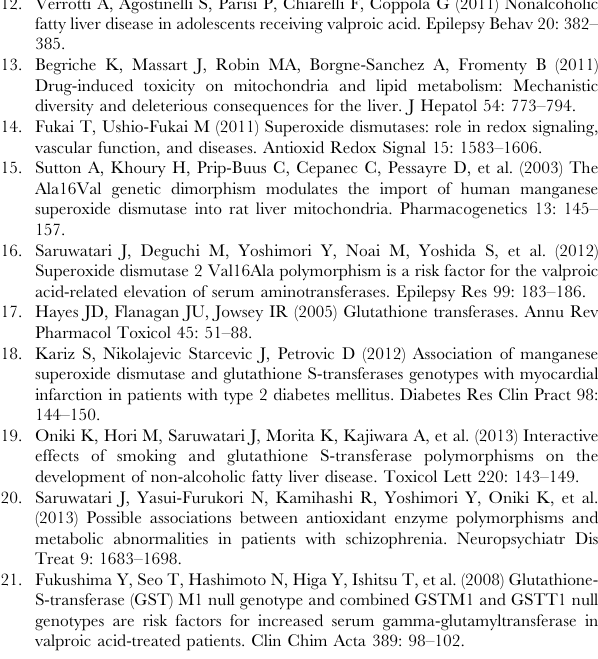
Figure S1 The goodness of fit of the final population PK model. The population-predicted (A) and individually-predicted (B) versus observed VPA concentrations in Japanese patients with epilepsy. The conditional weighted residuals versus population- predicted VPA concentrations in patients with epilepsy (C). Figure S2 The frequency distribution of the patient age for the datasets in the PK-PD analysis. Table S1 The effects of the tested covariates on the objective function of the PK parameters of VPA.